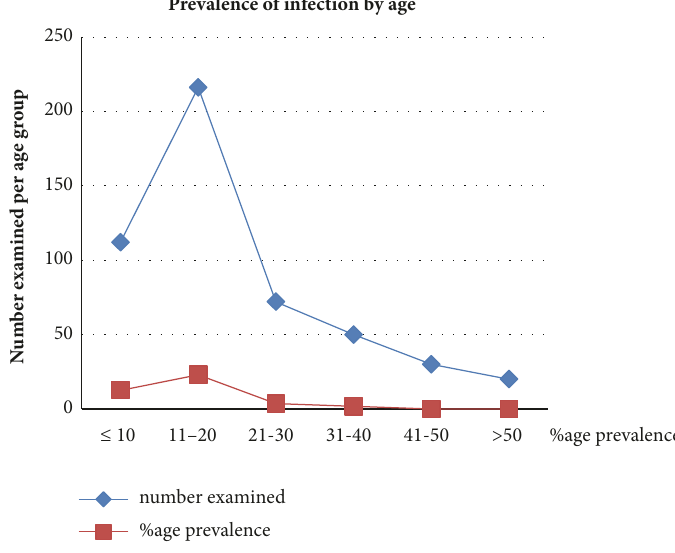
Figure 1: Prevalence of urogenital schistosomiasis by age.